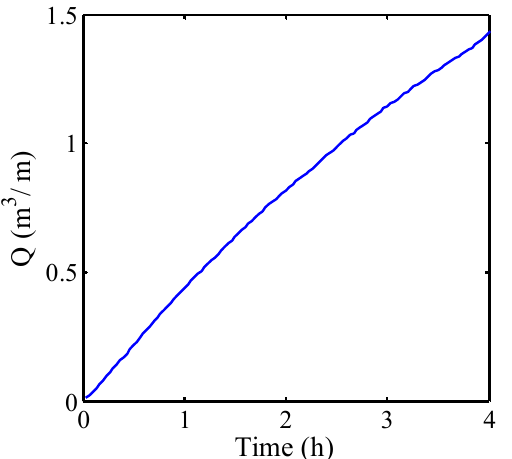
Figure 7. Revetment breakwater is being impacted by regular wave and water overtopping is occurring, observed in Test 3.